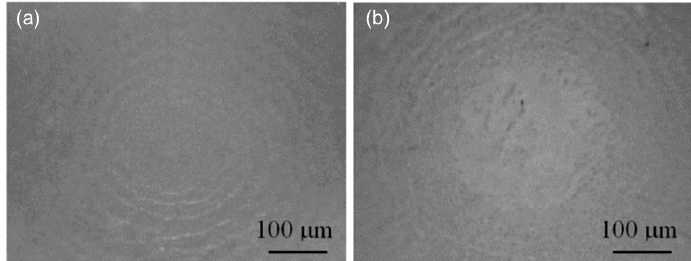
Figure 12. Surface changes on the polisher’s head ( a ) before polishing and ( b ) after polishing.